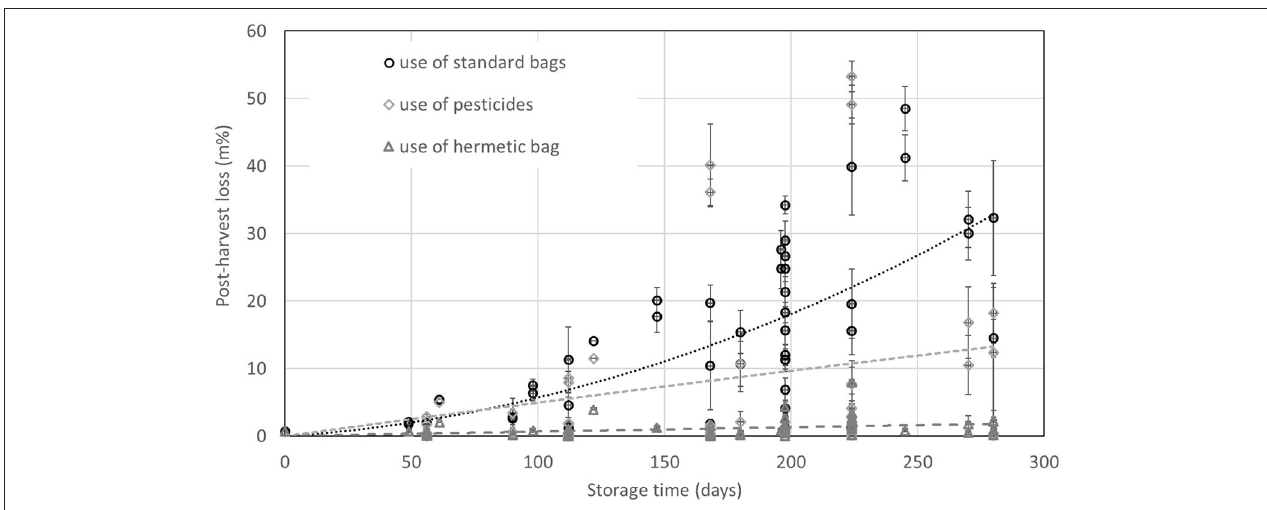
FIGURE 2 | Post-harvest weight loss in % in different storage scenarios [standard bags (circles), standard bags combined with pesticides (diamonds) and hermetic bags (crosses)] in field trials of maize storage, based on data from Likhayo et al. (2016), Ndegwa et al. (2016), Mlambo et al. (2017), Ng’ang’a et al. (2016b), and Baoua et al. (2014). The points are averages from a number of different samples, error bar represent the standard deviation. The regression lines are corrected for the underlying number of samples of the points.